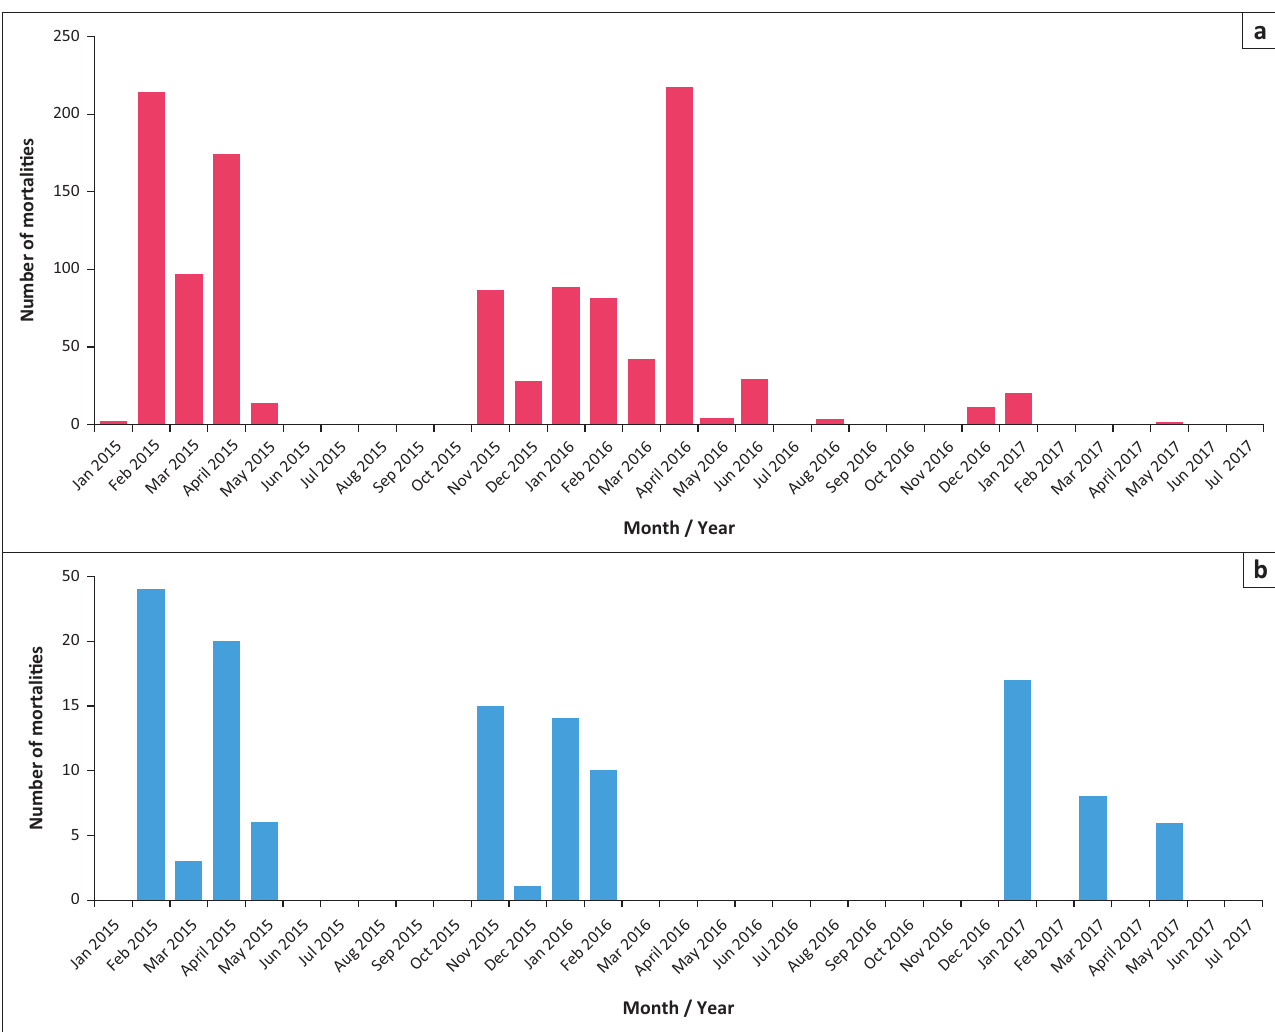
FIGURE 2: Number of (a) waterbird and (b) fish mortalities recorded in the Wilderness Lakes per month between January 2015 and July